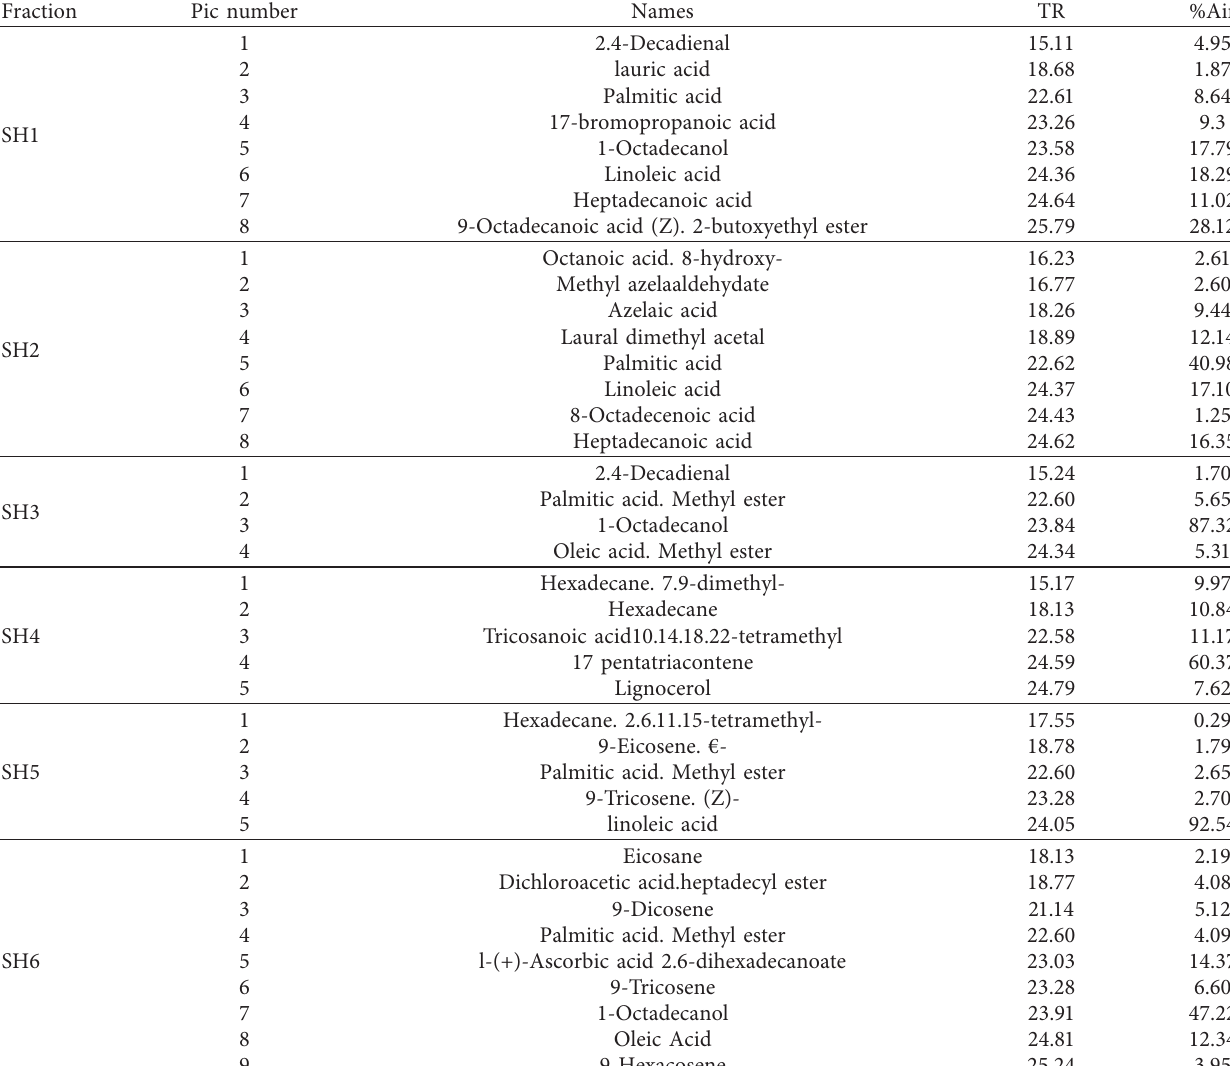
Table 3: Fraction chemical composition generated from the hexane mother extract and identified by GC-MS.